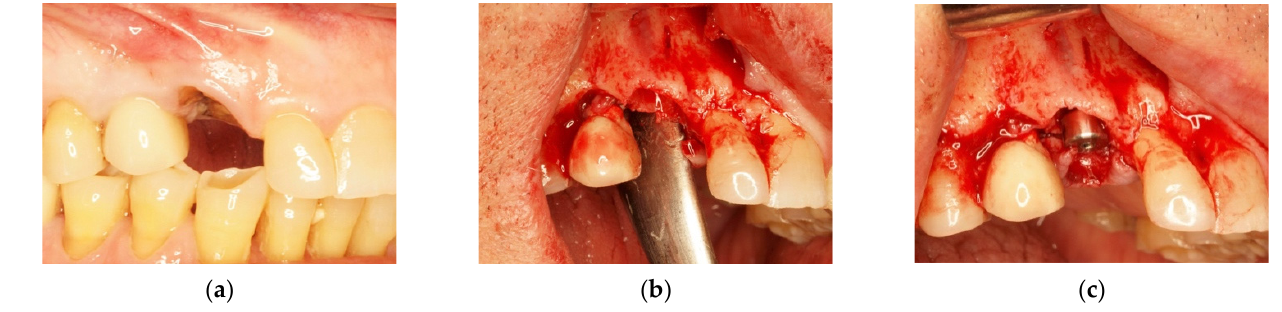
Figure 6. ( a ) Edentulous tooth site 13; ( b ) evaluation of the alveolus; ( c ) implant insertion.